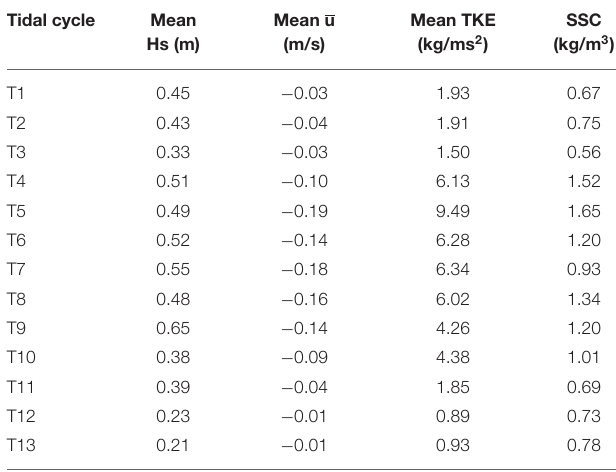
TABLE 2 | Tidal cycle-averaged significant wave height (Hs), cross-shore velocity ( u ), turbulent kinetic energy (TKE), and near-bed suspended sediment concentration (SSC) of the observation at Site